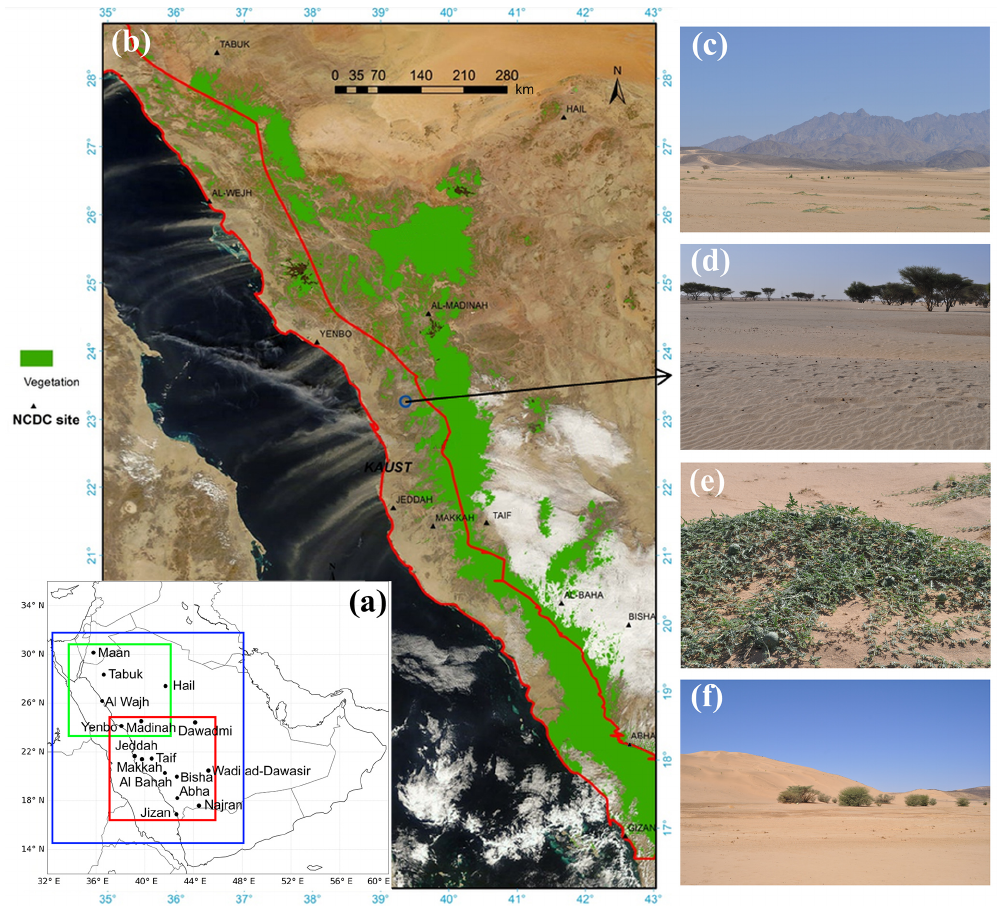
Figure 1. (a) The CLM4 model domains (green and red), WRF-Chem domain (blue), and 16 ground observation stations. (b) Dust plume above the Red Sea observed by MODIS/TERRA at 07:45UTC on 14 January 2009. Overview of the landscapes: (c) piedmont, (d) trees over the sand, (e) wild watermelons over the sand, and (f) sand dunes and scattered vegetation.